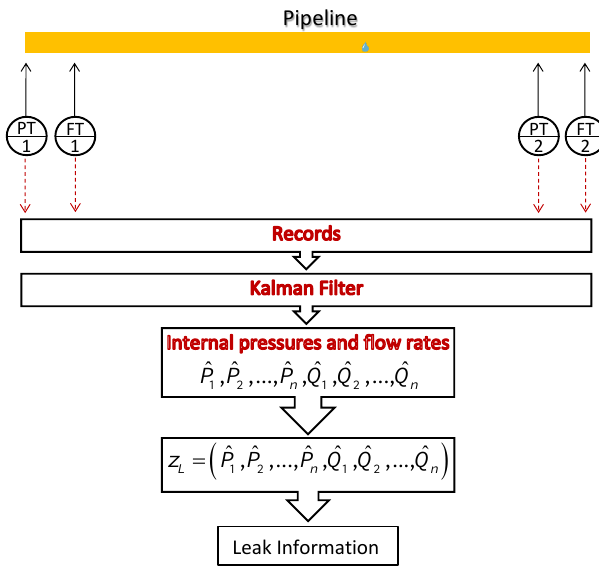
Figure 6. Architecture of approaches based on the estimation of internal pressures and flow rates.